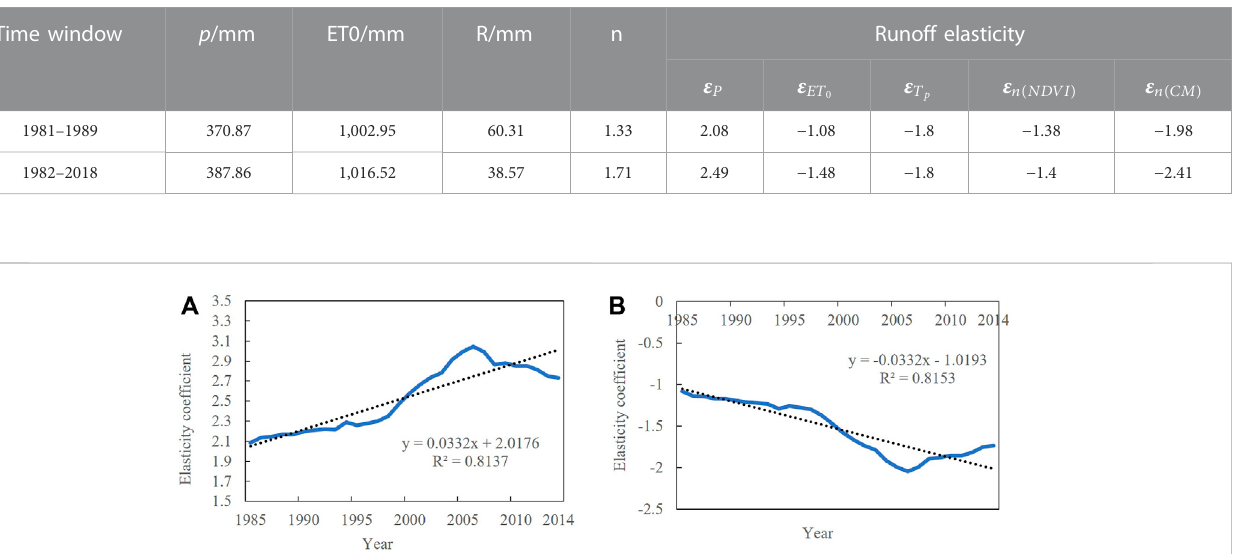
Frontiers in Earth